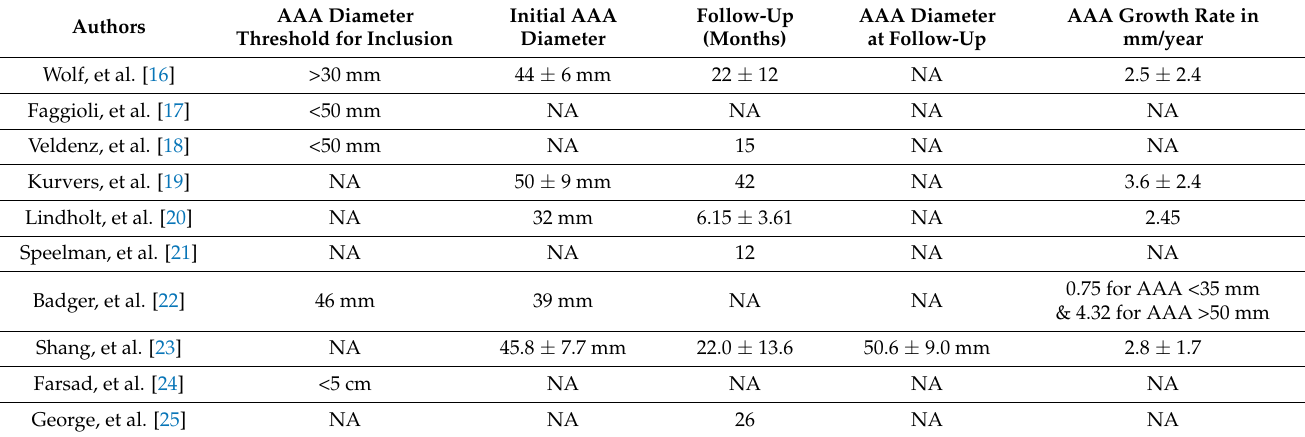
Table 3. Abdominal aortic initial diameter was reported in 13 studies and ranged between 19.9 and 50.9